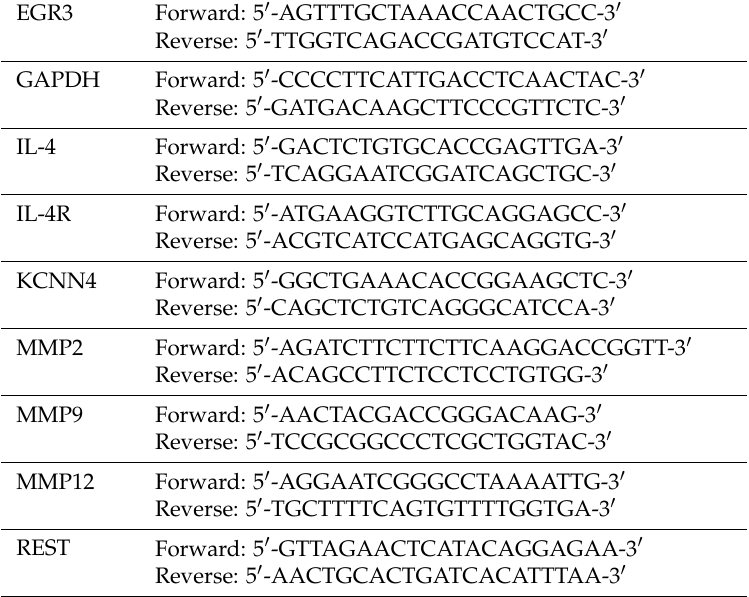
Figure S1: MTT assay on irradiated GL-15 cells, Figure S2: Radiation-induced KCa3.1 activity is repressed